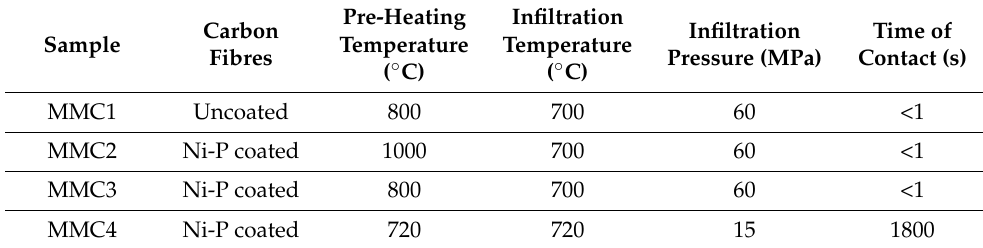
Table 1. Fabrication parameters of the investigated samples. Table 1 . Fabrication parameters of the investigated samples.